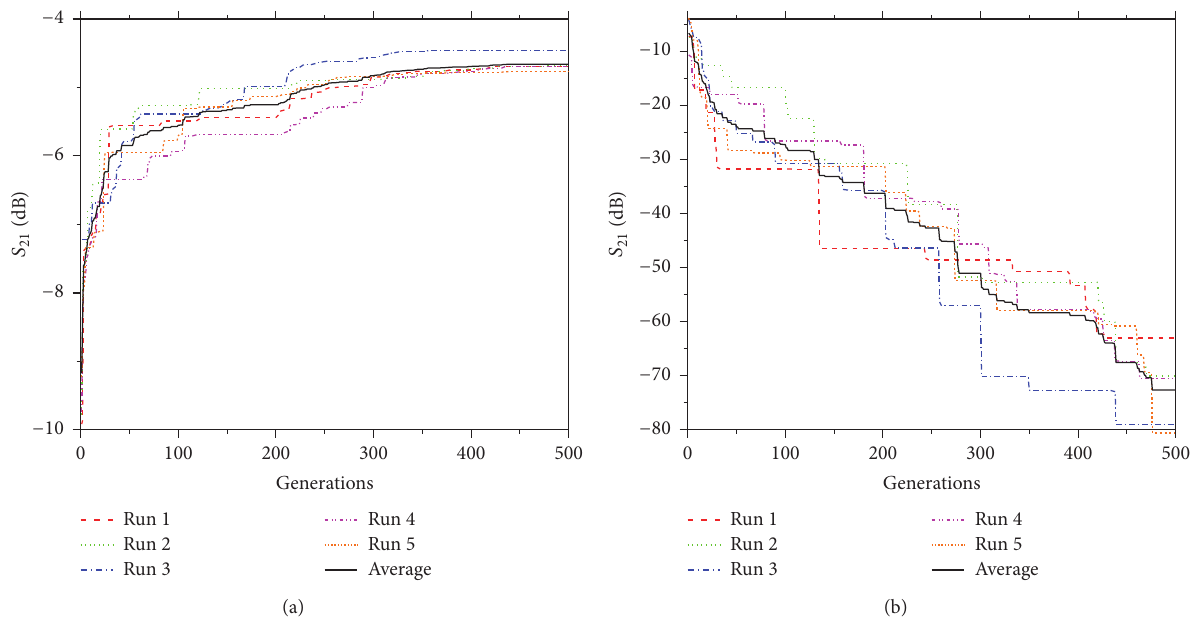
Figure 11: 𝑆 21 variation of the GA procedure. (a) High-gain mode. (b) Nulling mode.